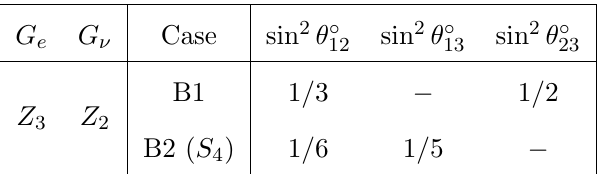
for viable cases originating from G f = S 4 broken ij